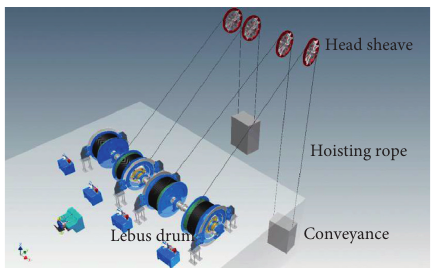
Figure 1: Schematic of a Blair mine hoist in superdeep mine